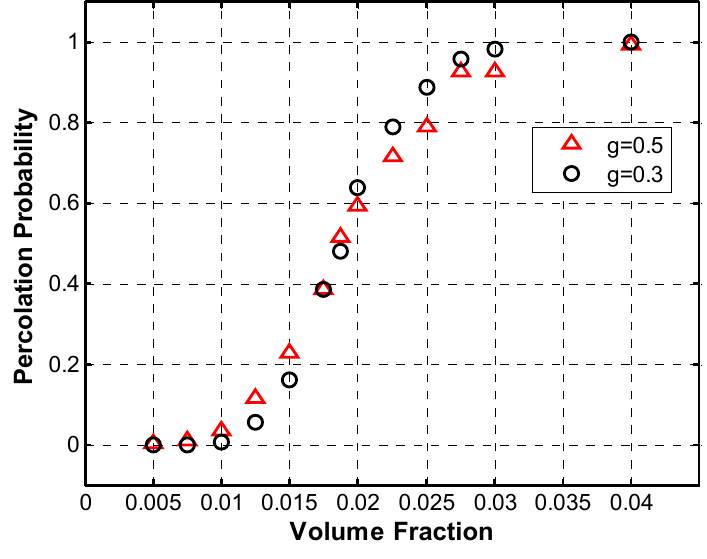
Figure 21. Percolation probability curves intersect at percolation threshold, AR = 240.